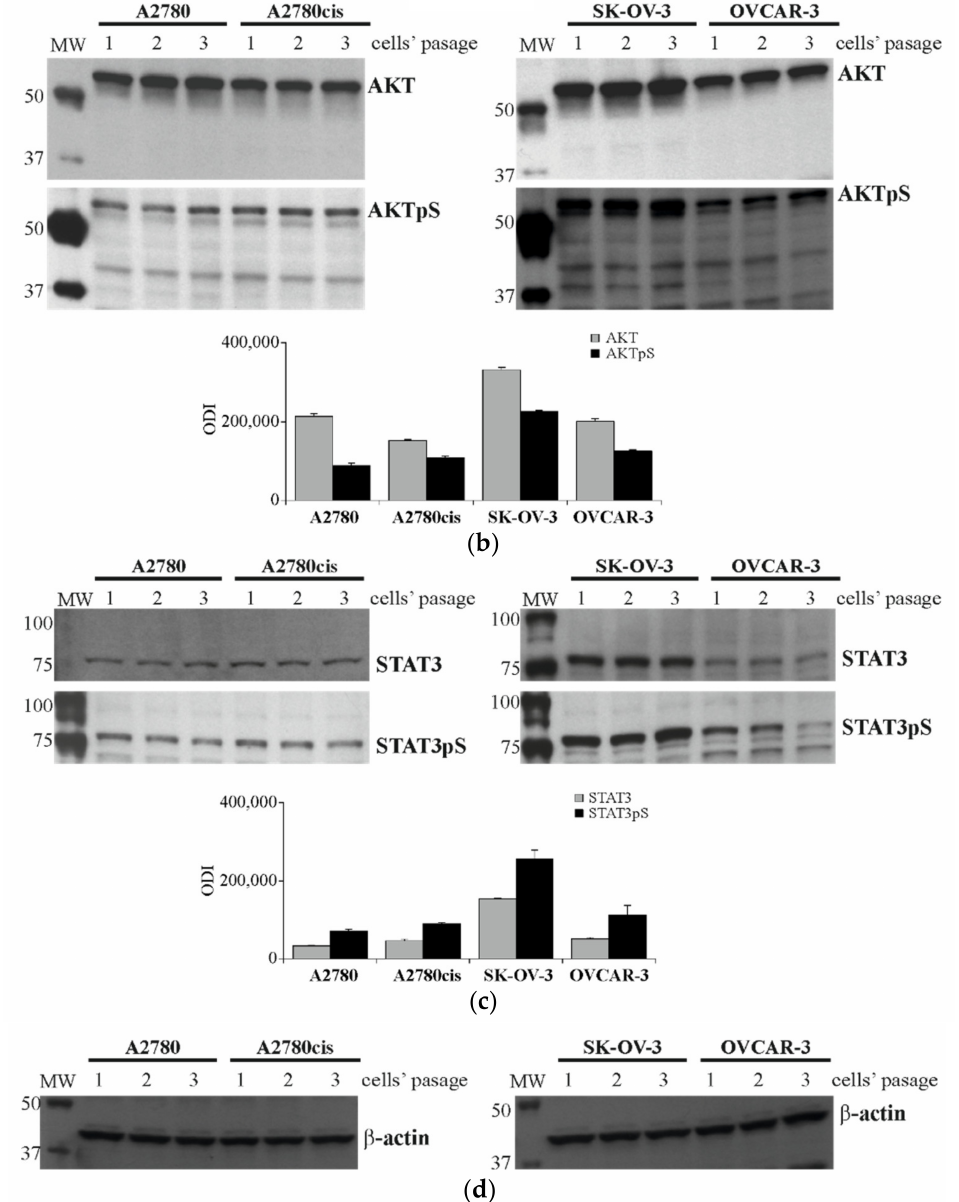
Figure 5. The total and phosphorylation level of ERK 1/2, AKT and STAT3 signaling proteins in A2780, A2780cis, SK- OV-3 and OVCAR-3 cell lines. Cultured cells were harvested, lysed and the level of total and phosphorylated proteins was determined with Immunoblotting-ECL method. Representative immunoblots of ERK 1/2 ( a ), AKT ( b ), STAT3 ( c ). Additionally, β -actin ( d ) was used as a loading control for all samples. Bands were quantified by densitometric analysis and data are presented as the optical density intensity (ODI) of the area under each band’s peak ± SD from three independent experiments ( n =